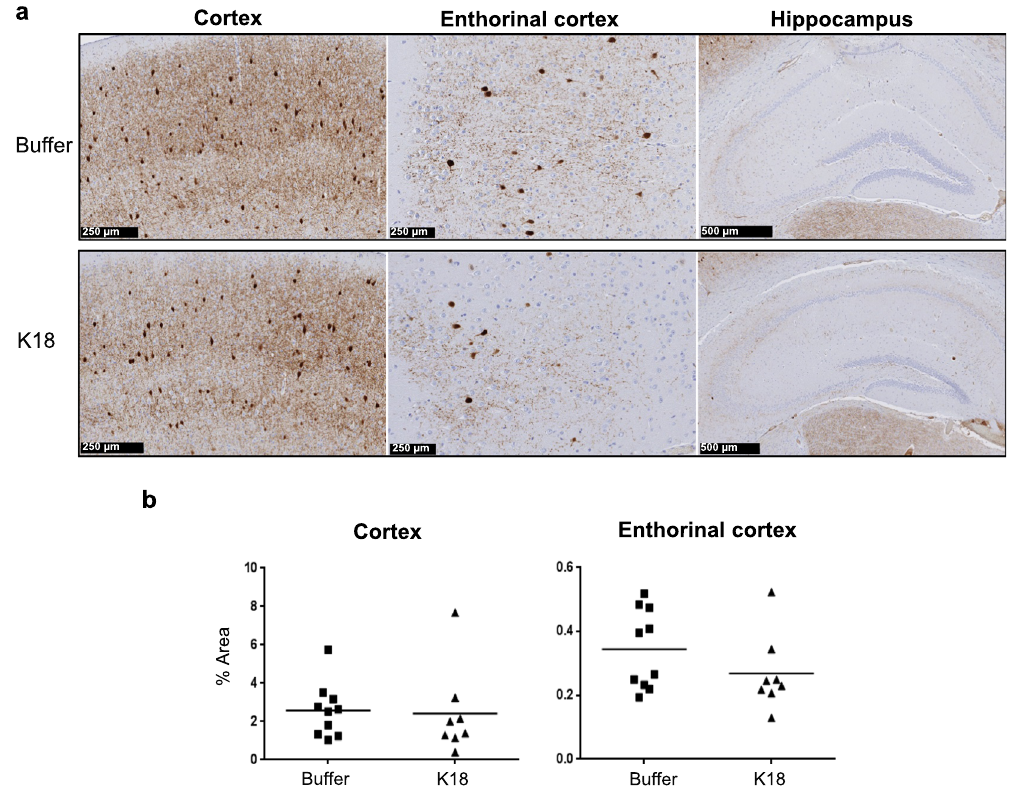
Figure 7. ( a ) Immunohistochemical difference in PV + cells in hippocampal, frontal and entorhinal cortical structures of mice injected with the buffer (upper panel images) or K18 (bottom panel images). ( b ) Quantification of PV + cell loss in the cortex and enthorinal cortex. Scatter plot shows no major difference in the average number of PV + cell loss in cortical structures, whilst limited PV cells were detected in the hippocampus. Accurate quantification of PV + was difficult in 2 animals, which were discarded from the anlaysis. One way ANOVA, Bonferroni correction for multiple comparisons, significance levels p < 0.05, K18 (n = 8) vs buffer (n = 10). Scale bars 250 and 500 µ